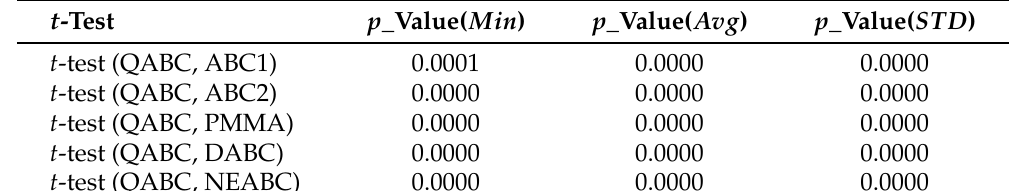
Table 9. Results of paired sample t -test.